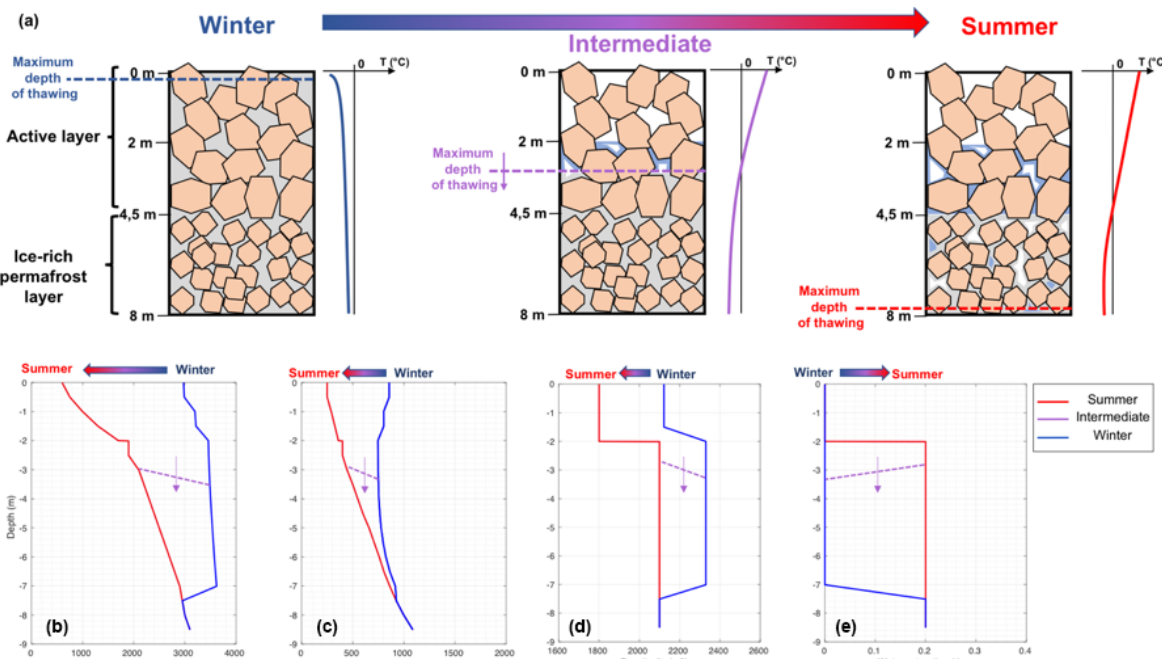
Figure 7. (a) Schematic cross section of the Gugla rock glacier in winter (left), in summer (right) and during the transition between them (in- termediate state of thawing, middle), as well as a schematic temperature profile associated with each of them, showing the main assumptions of the freezing modeling methodology by a poroelastic approach described in the text. The porous medium is composed of a rock matrix (in orange) and pores filled by water (in blue) or ice (in grey). With respect to the maximum depth of thawing varying from the surface to the ZAA depth, the evolution of parameters used by the model is shown as follows: P-wave velocity (b) , S-wave velocity (c) , the averaged den- sity (d) and the water saturation (d) . The values in summer are obtained from geophysics and boreholes, whereas the values corresponding to a frozen state (pores fully filled by ice, no more liquid water) are obtained by the three-phase poroelastic model.